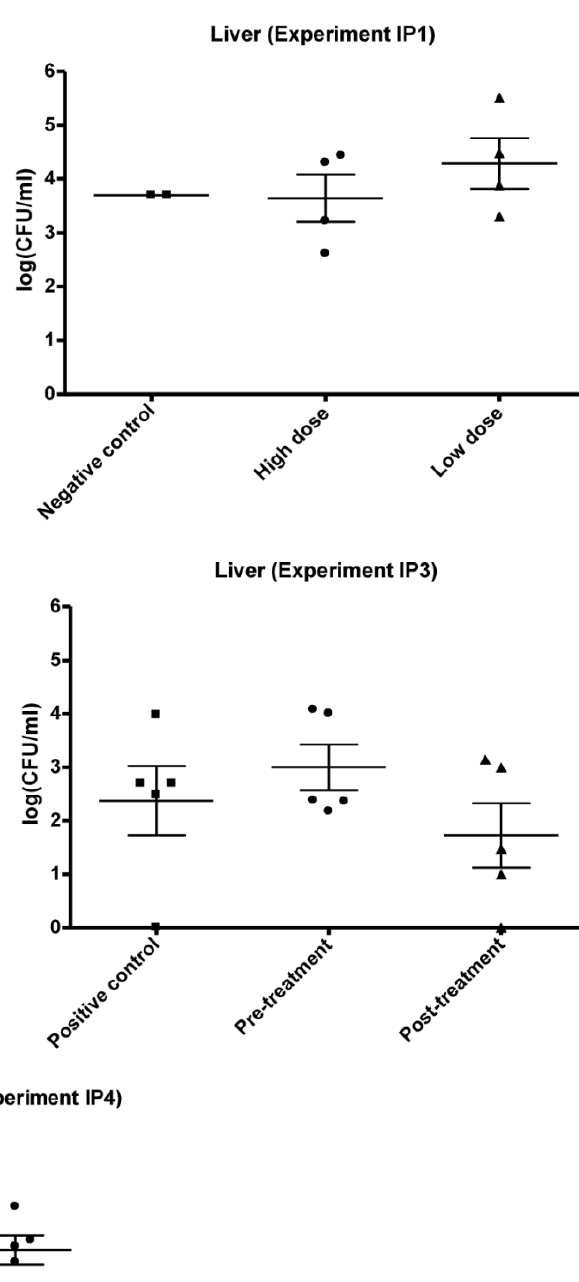
Figure 3. Results of mouse experiment IP0, IP1, IP2, IP3 and IP4: Scatter plots of bacteria detected in liver after cultivation on 5% horse blood agar plates. The values are plotted as log CFU/mL. Group A IP0 not